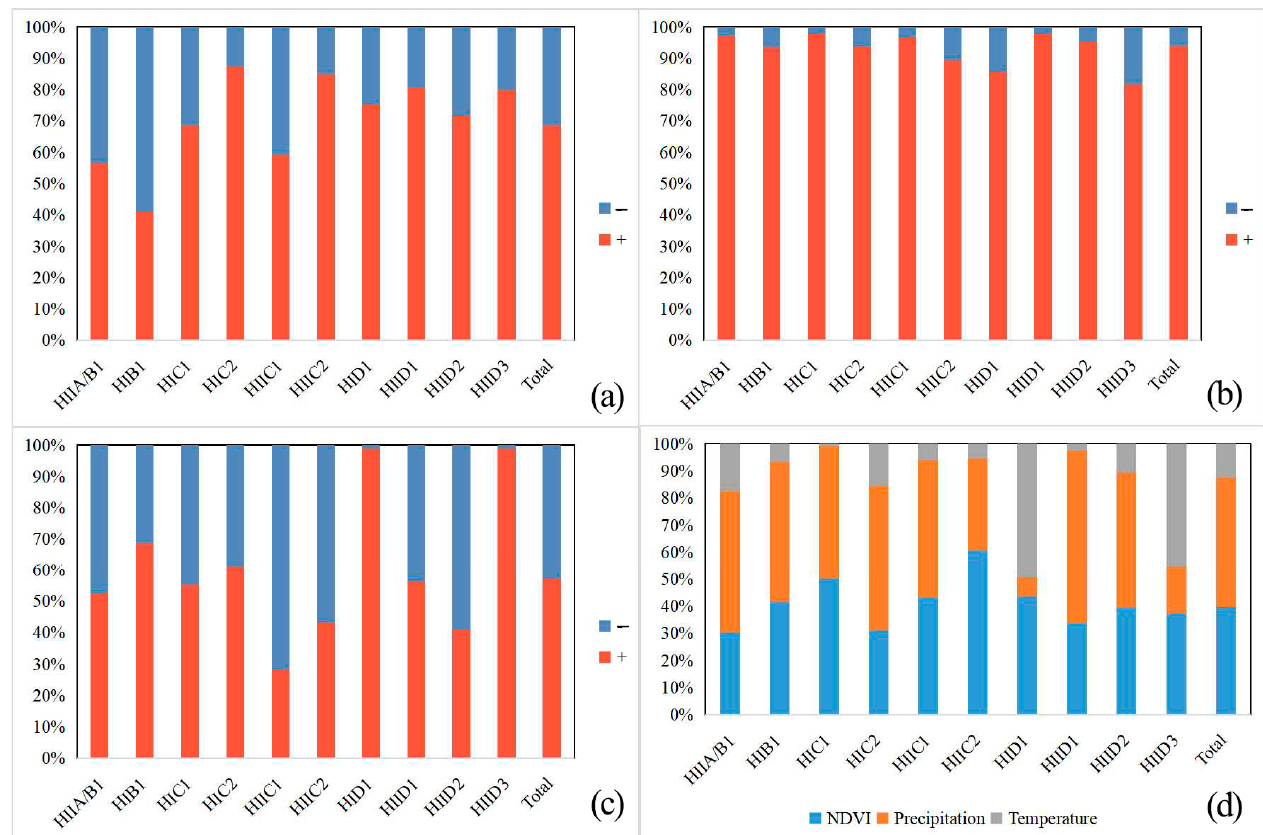
Figure 4. Percentage statistics of positive and negative correlations of ( a ) NDVI, ( b ) precipitation, and ( c ) temperature with SM; ( d ) area percentage of dominant factors.